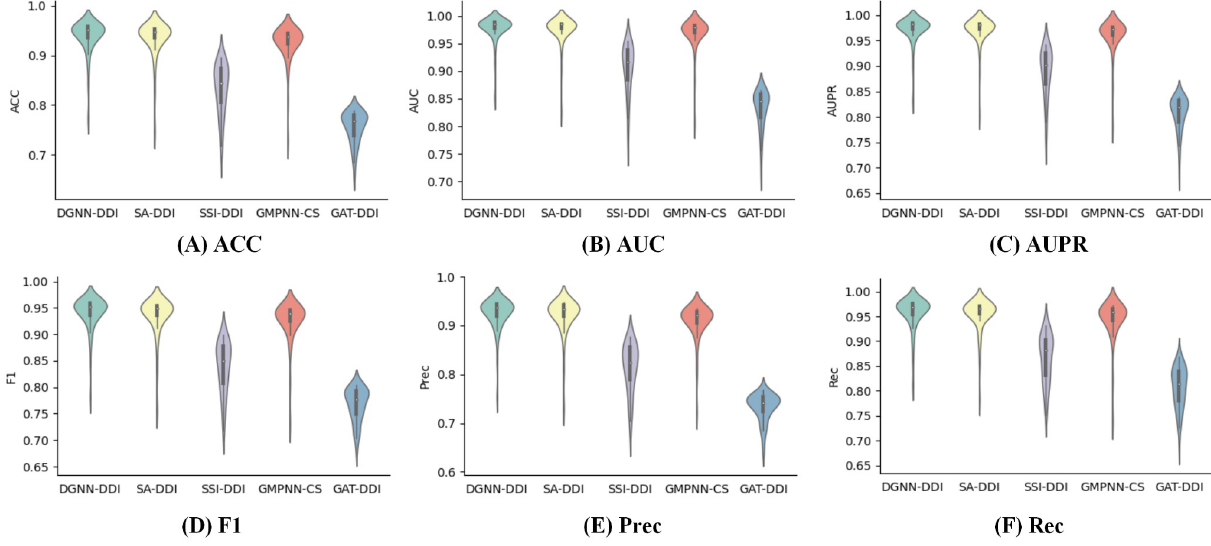
Fig 1. Violin plots displaying metric scores of all